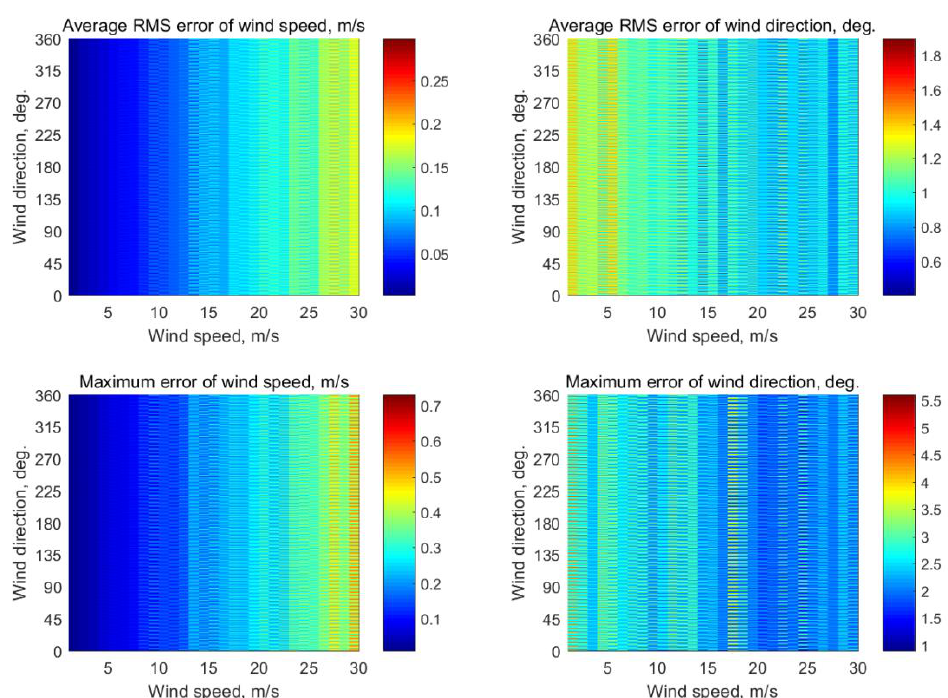
Figure A15. Simulation results of the use of three incidence angles of 35°, 40°, and 45° for wind retrieval.